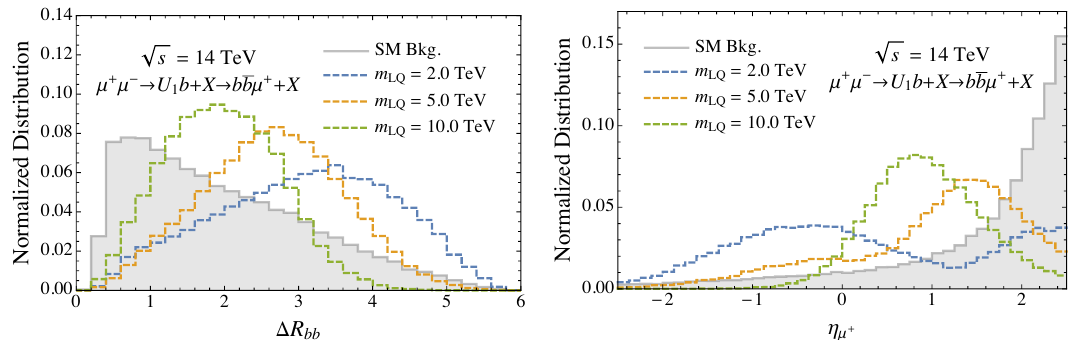
Figure 7 . Normalized distributions of the angular distance, ∆ R between the b -pair (left) and of the pseudorapidity of the µ + in single production. The SM background is shown as a gray, shaded histogram while the colored curves show the LQ signal for several values of the LQ mass. The histograms motivate some cuts on ∆ R bb and η µ